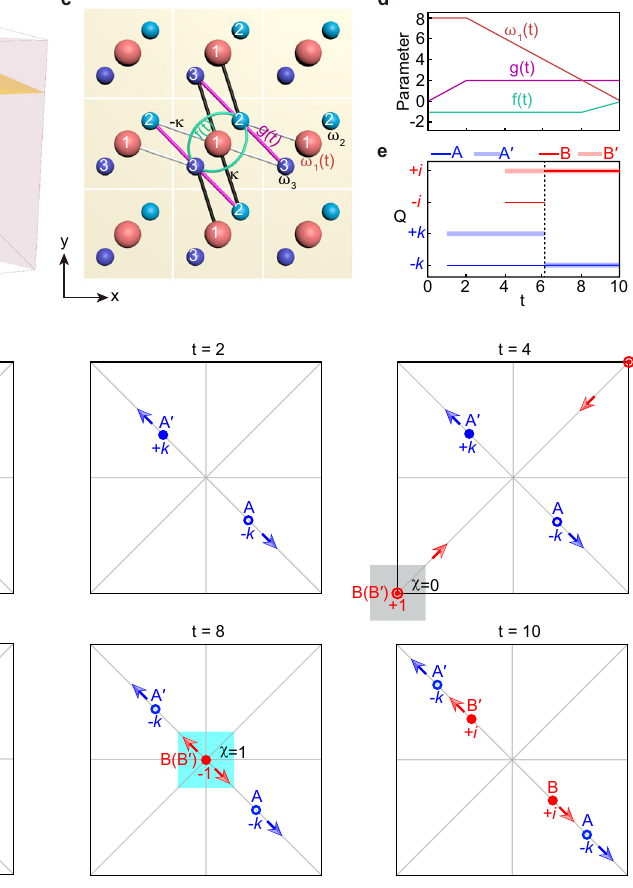
of onsite energies ω 1 t ð Þ and ω 2,3 =0 are coupled with hoppings ± κ , f ð t Þ , and g ð t Þ . d Time dependence of ω 1 t ð Þ , f ð t Þ , and g ð t Þ . e Time evolution of the nodal charges. f Momentum distributions of the band nodes and their charges at eight different moments, illustrating the braiding process in ( b ). The gray and cyan areas in t =4 and 8 indicate the patch Euler classes χ =0 and χ =1, respectively. The colored arrows indicate the subsequent movements for the corresponding